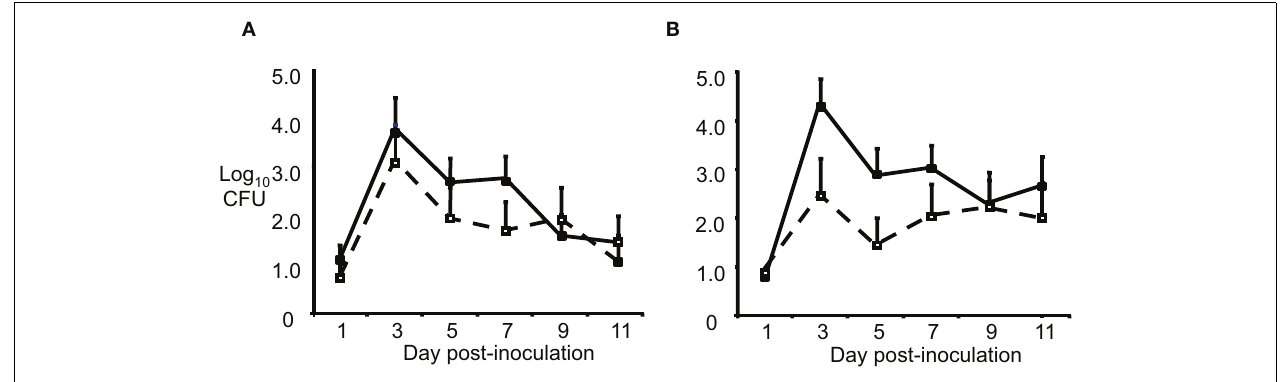
for 11days.The average log 10 CFU per 100 μ l vaginal swab suspension over time is shown with standard error bars.There was no difference in the number of GC recovered (repeated measures ANOVA) or duration of colonization (Log rank test) for any experimental group.This experiment was repeated using three IN immunizations and another experiment was performed with strain MS11 and an MS11 lst mutant, and the results were